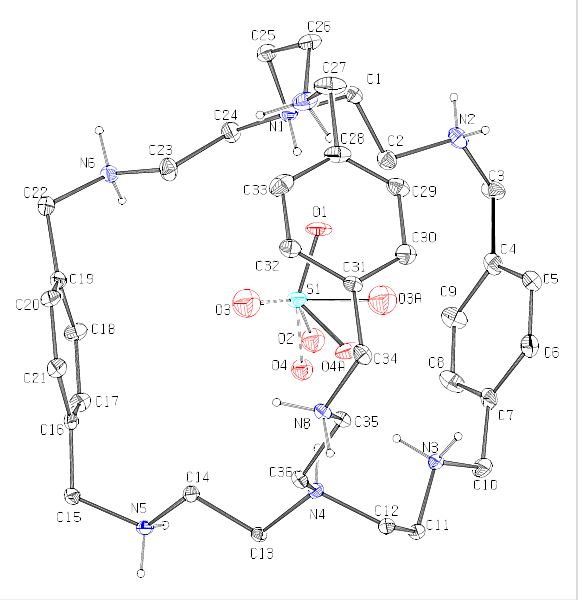
Figure 4: ORTEP diagram with atom numbering scheme depicting the octaprotonated L 1 with disordered HSO 4− monoanion inside the cavity (25% probability factor for the thermal ellipsoids and only hydrogen atoms attached to the amino nitrogens are shown in the figure for clarity).